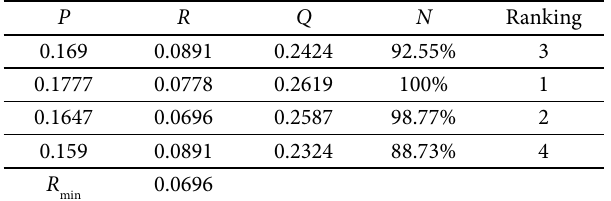
Table 6. Final results and